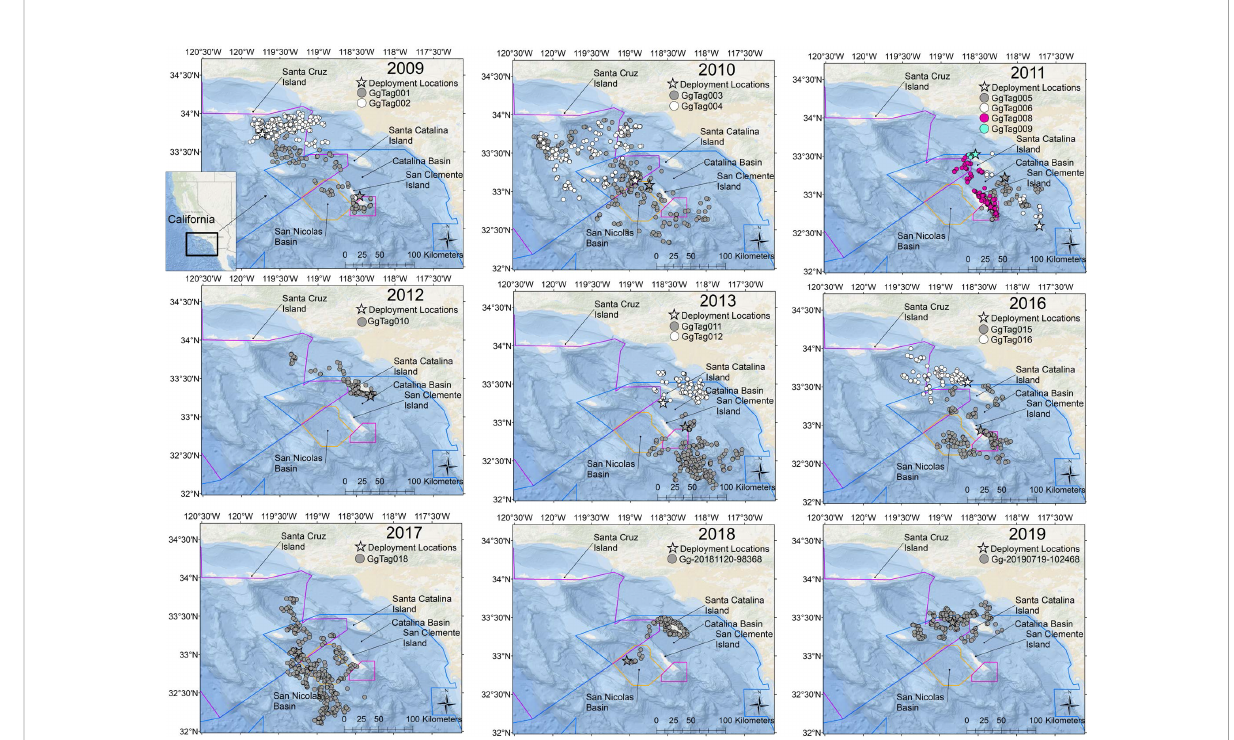
FIGURE 1 Maps of the study area with fi ltered locations of Risso ’ s dolphins tagged within the Southern California Bight annually. The inset shows the study area in a broader geographic context of the state of California. Range Polygons: Blue = Southern California Range Complex; Purple = Point Mugu Sea Range; Orange = Southern California Anti-submarine Warfare Range; Pink = Shore Bombardment